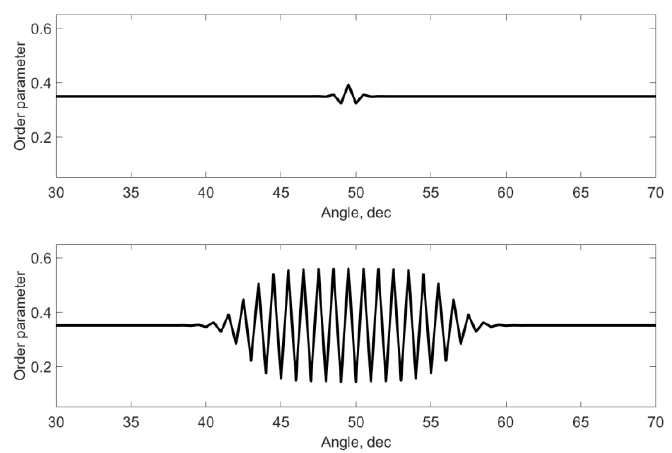
Figure 4. Dynamics of the order parameter distribution depending on the radius in the vicinity of the defect.